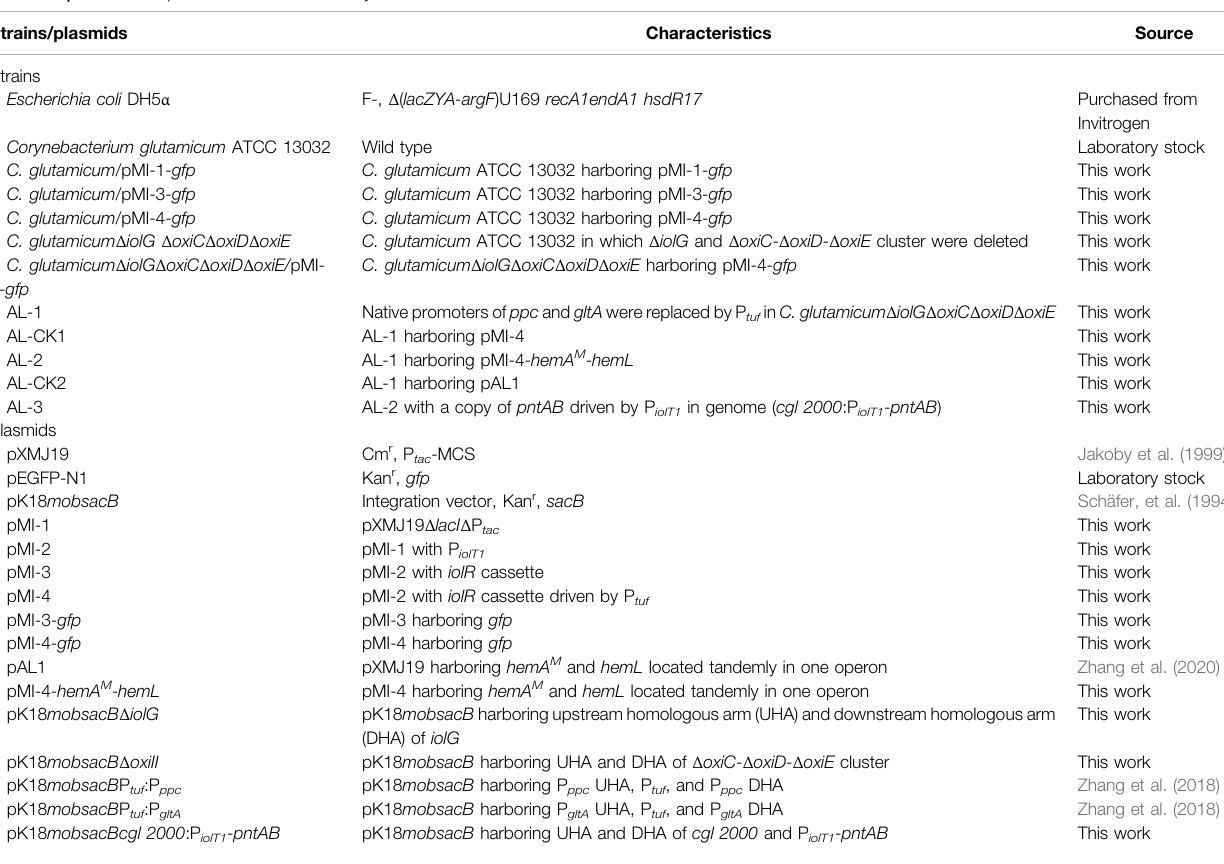
TABLE 1 | Strains and plasmids used in this